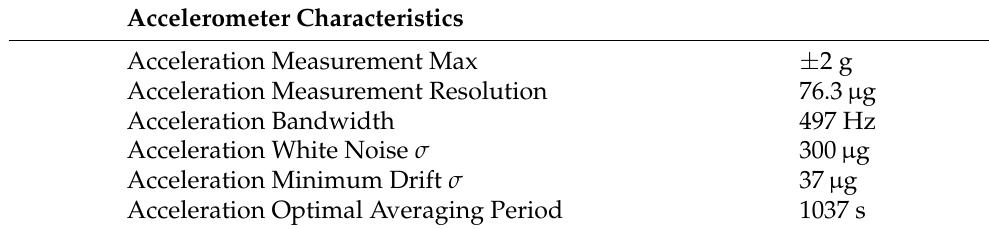
Table 1. Accelerometer